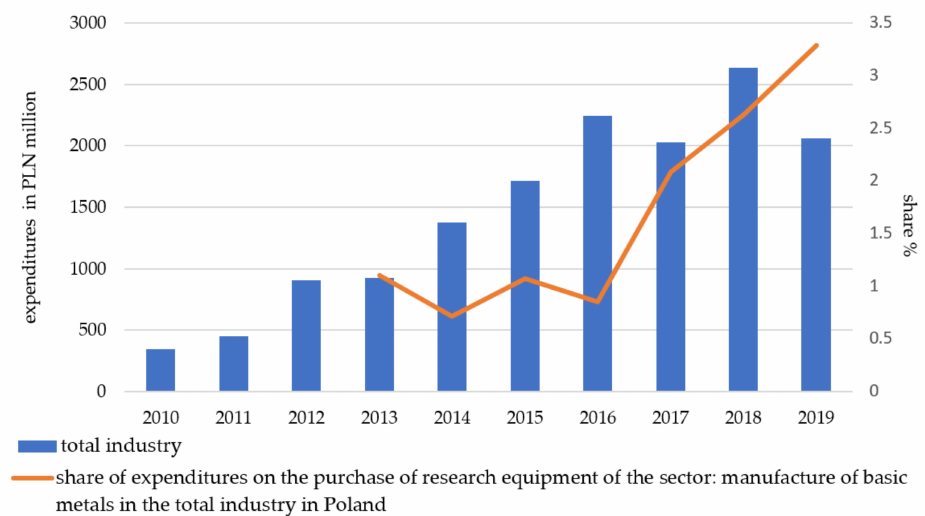
Figure 9. Shares of investment expenditure on R&D in the total expenditure in the manufacture of basic metals and in the total industry in Poland. Source: adapted with permission from Refs.